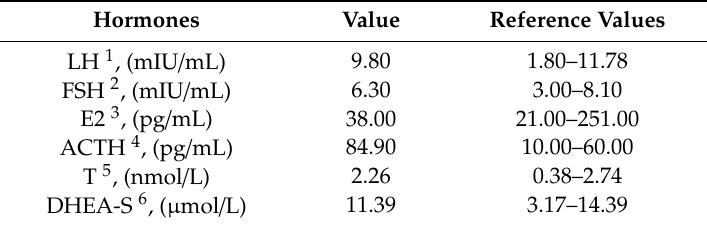
Table 1. Results of basic hormonal serum estimations.